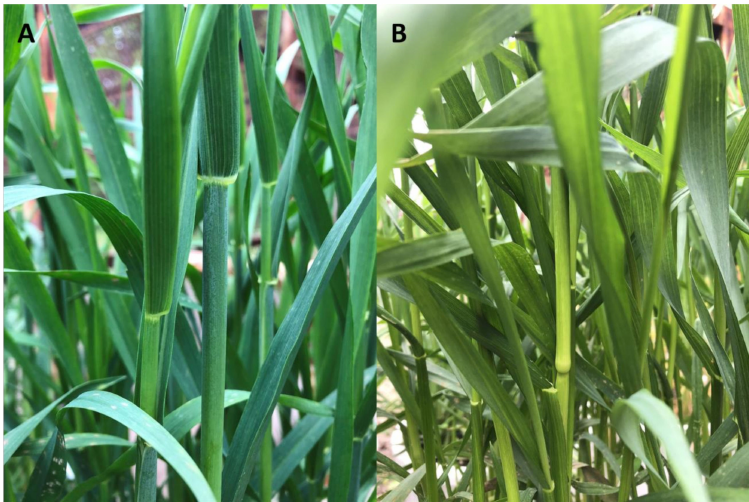
Figure 1. Stems and leaves of parental components of rye mapping population BK2: glaucous inbred line AK1 ( A ) and nonglaucous AKZ ( B